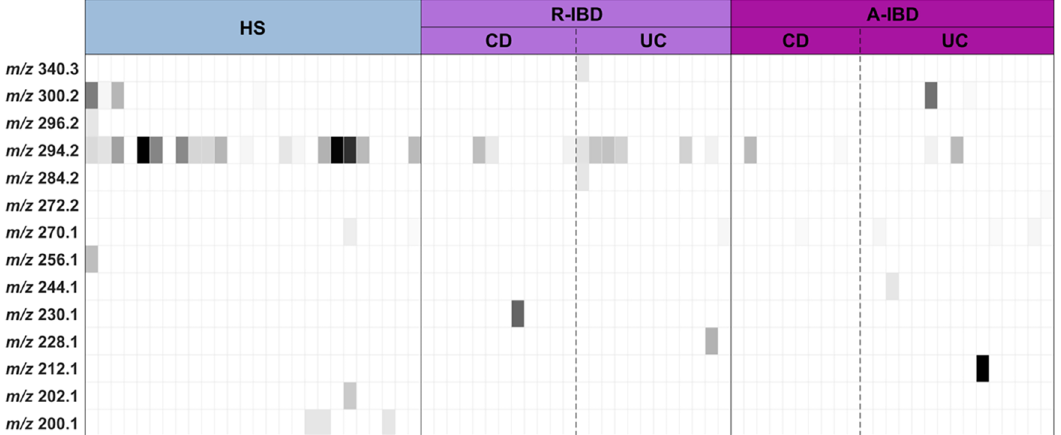
Fig 1. Heatmap of the results of the AHL profile in IBD patients and healthy controls. AHLs are designated by their m/z. The grey colour bar indicates AHL m/z concentrations from none (white) to highest concentration (black). HS: healthy subject, R-IBD: inflammatory bowel disease patients in remission, A-IBD: inflammatory bowel disease patients in flare, UC: ulcerative colitis, CD: Crohn’s disease.